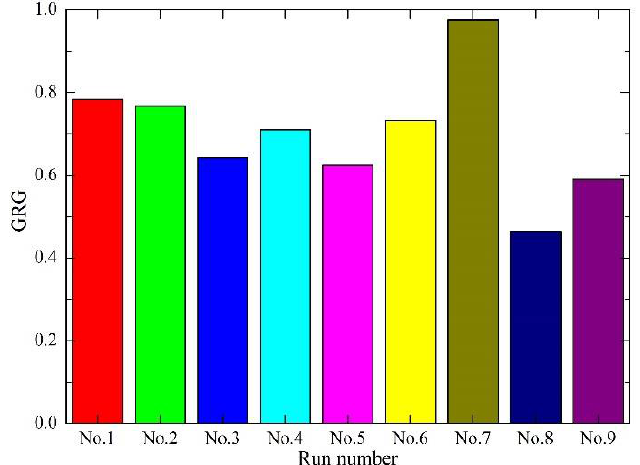
GRG1 in Table 4 represents gray relational grade of stiffness, GRG2 in Table 4 represents gray relational grade of stress. Figure 15. Comprehensive GRG for different Run number. Figure 15. Comprehensive GRG for different Run